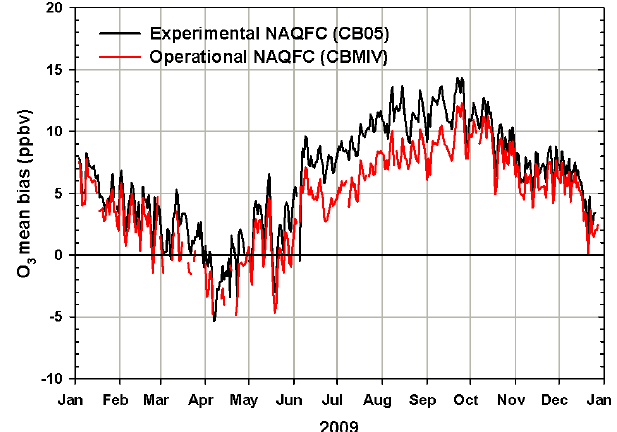
Figure 1 . Mean bias of ground-­‐level ozone from parallel versions of the NAQFC. Ozone 4 Fig. 1. Mean bias of ground-level ozone from parallel versions of measurements are from the U. S. EPA Air Quality System (AQS) measurement network. 5 the NAQFC. Ozone measurements are from the US EPA Air Quality Operational NAQFC (red) and experimental NAQFC (black) mean biases (ppbv) calculated 6 as a CONUS-­‐wide average of (model – AQS) site biases. 7 System (AQS) measurement network. Operational NAQFC (red) 8 and experimental NAQFC (black) mean biases (ppbv) calculated as a CONUS-wide average of (model – AQS) site